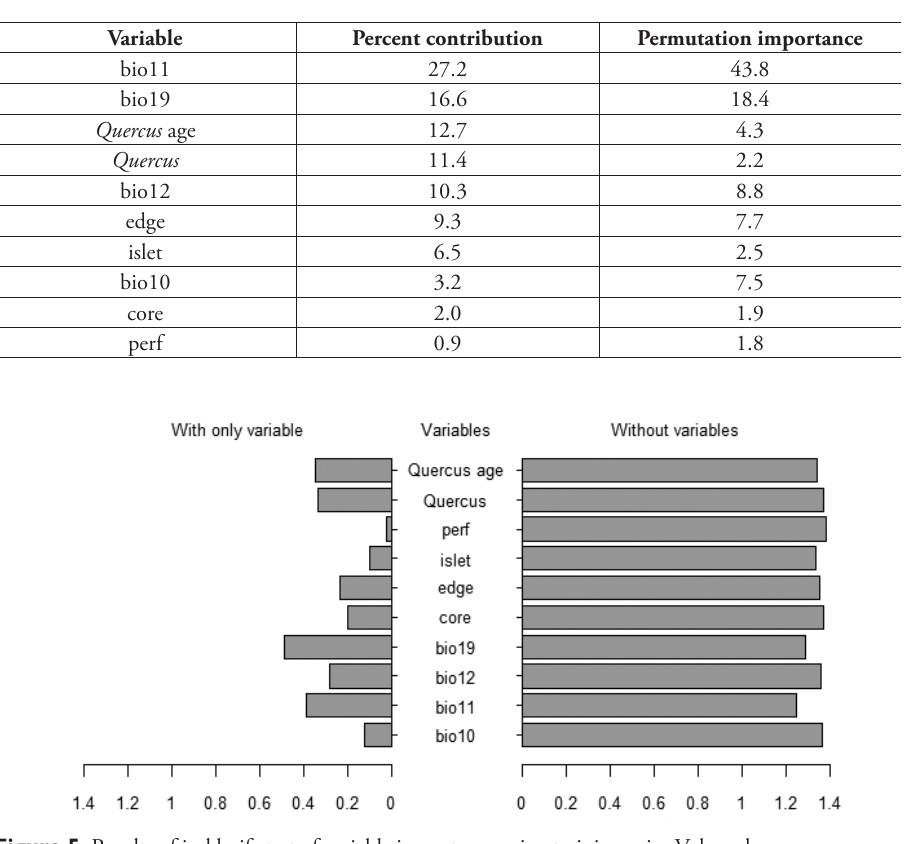
Table 2. The relative contributions and permutation importance of the environmental variables to the MaxEnt model. Values shown are averages over replicate